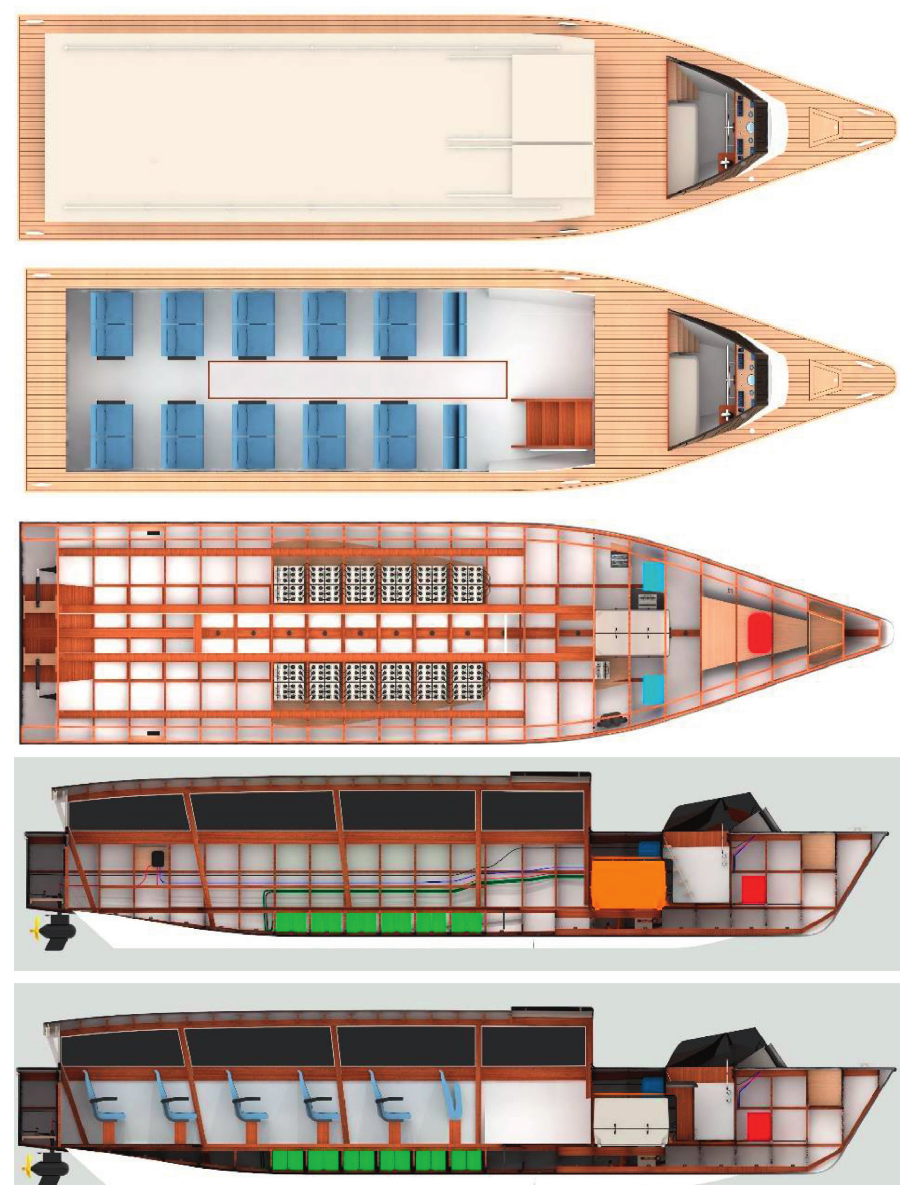
Figure 5: General arrangement plan and longitudinal